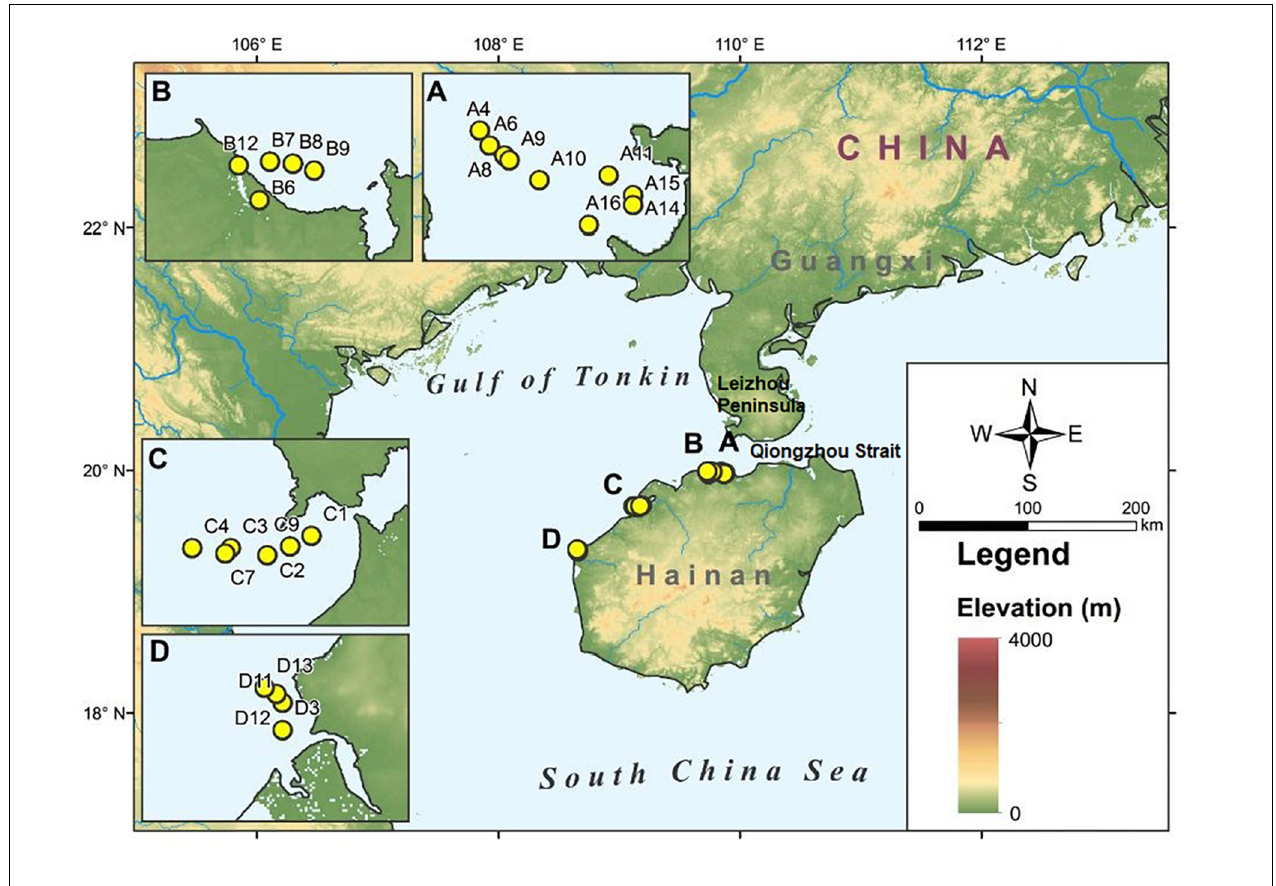
FIGURE 2 | Map of Gulf of Tonkin showing locations of surface sediments collected for the geochemical study. Samples were collected along four transects, namely Chengmai (A) , Lingao (B) , Baimajing (C) , and Changhua (D) . Also shown are enlarged views of these transects and surface sediments locations with sample